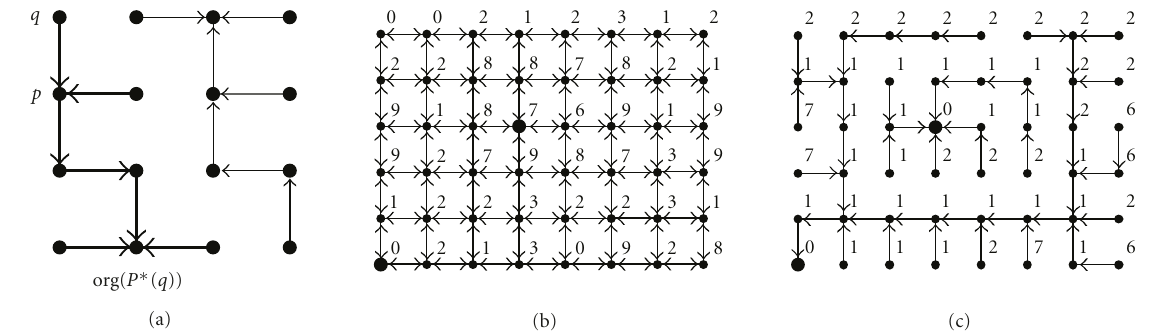
Figure 1: (a) The main elements of a spanning forest with two roots, where the thicker path indicates P ∗ ( q ). (b) An image graph with 4-adjacency, where the integers are the image values I ( p ) and the bigger dots indicate two seeds. One is inside the brighter rectangle and one is in the darker background outside it. Note that the background also contains brighter parts. (c) An optimum-path forest for f max , with δ ( p , q ) = | I ( q ) − I ( p ) | . The integers are the cost values, and the rectangle is obtained as an optimum-path tree rooted at the internal